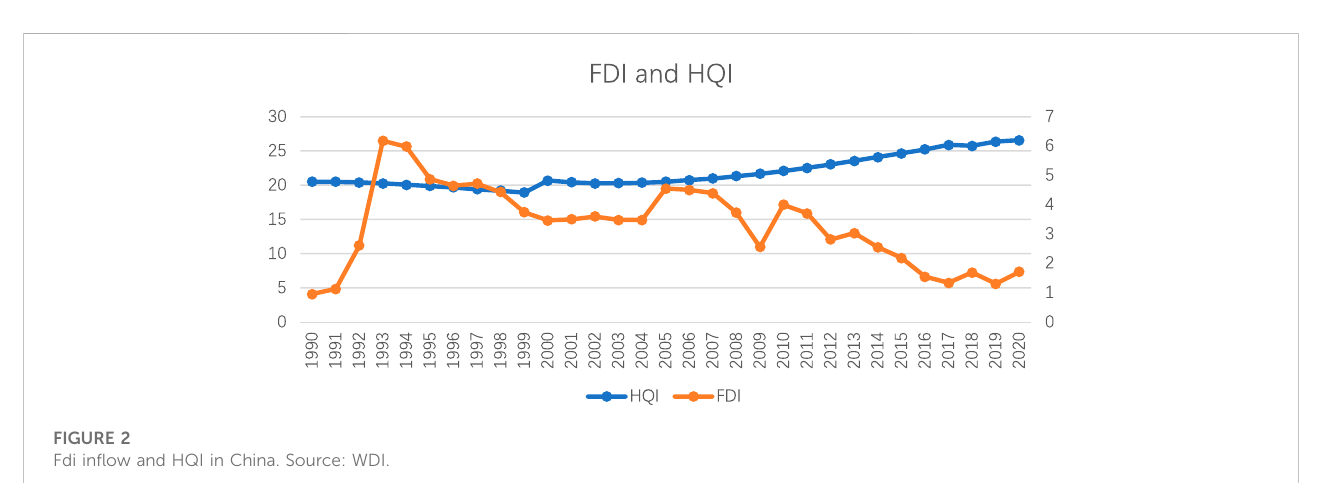
FIGURE 2 Fdi in fl ow and HQI in China. Source: WDI.